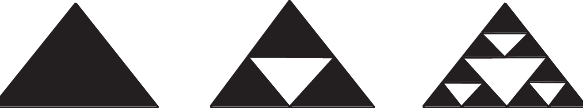
Figure 10: The Sierpinski gasket